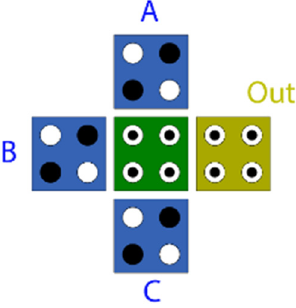
Figure 2: Cell con fi gurations of majority block.